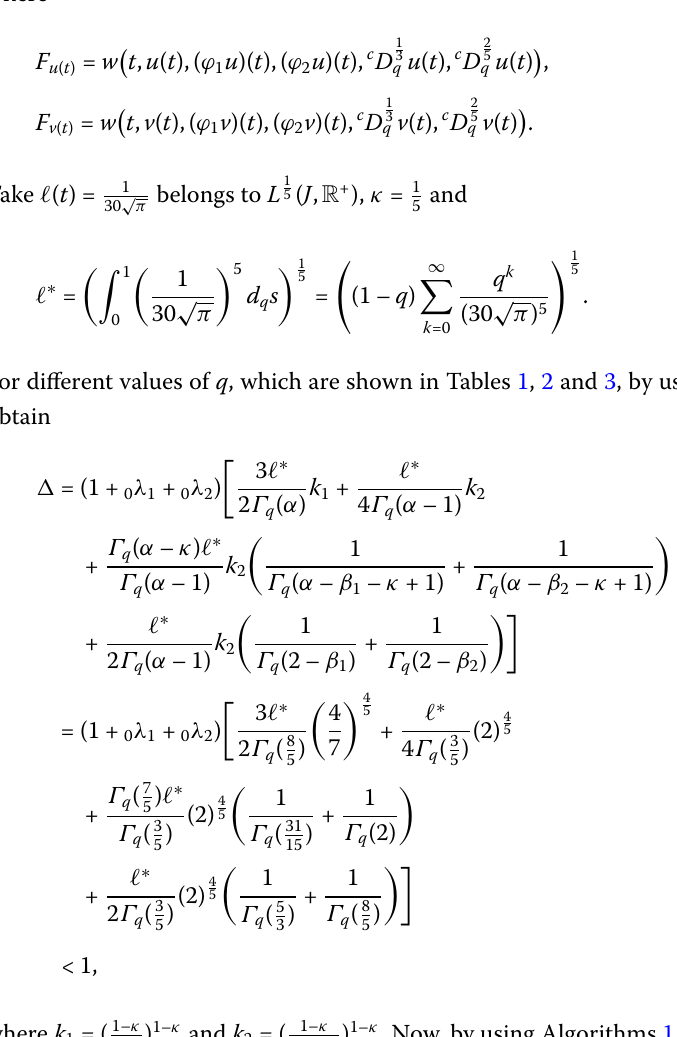
Table 1 Some numerical results for calculation of (cid:13) with q = 1 n 0 λ 1 0 λ 2 (cid:11) ∗ Ω (cid:13)